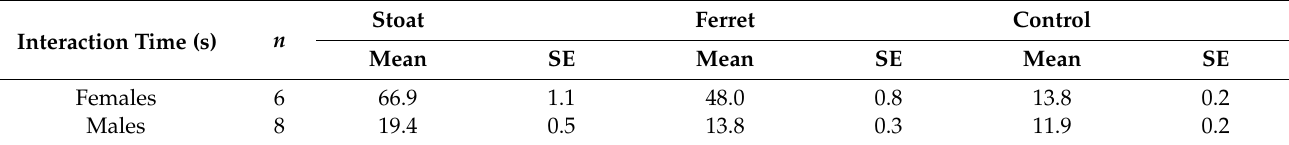
Table 2. Mean ( ± SE) time spent by stoats interacting with the bedding odour of an oestrous female stoat, and a female ferret during spring, summer and autumn. The odours were collected on Dacron bedding material and compared with a blank piece of Dacron (control).